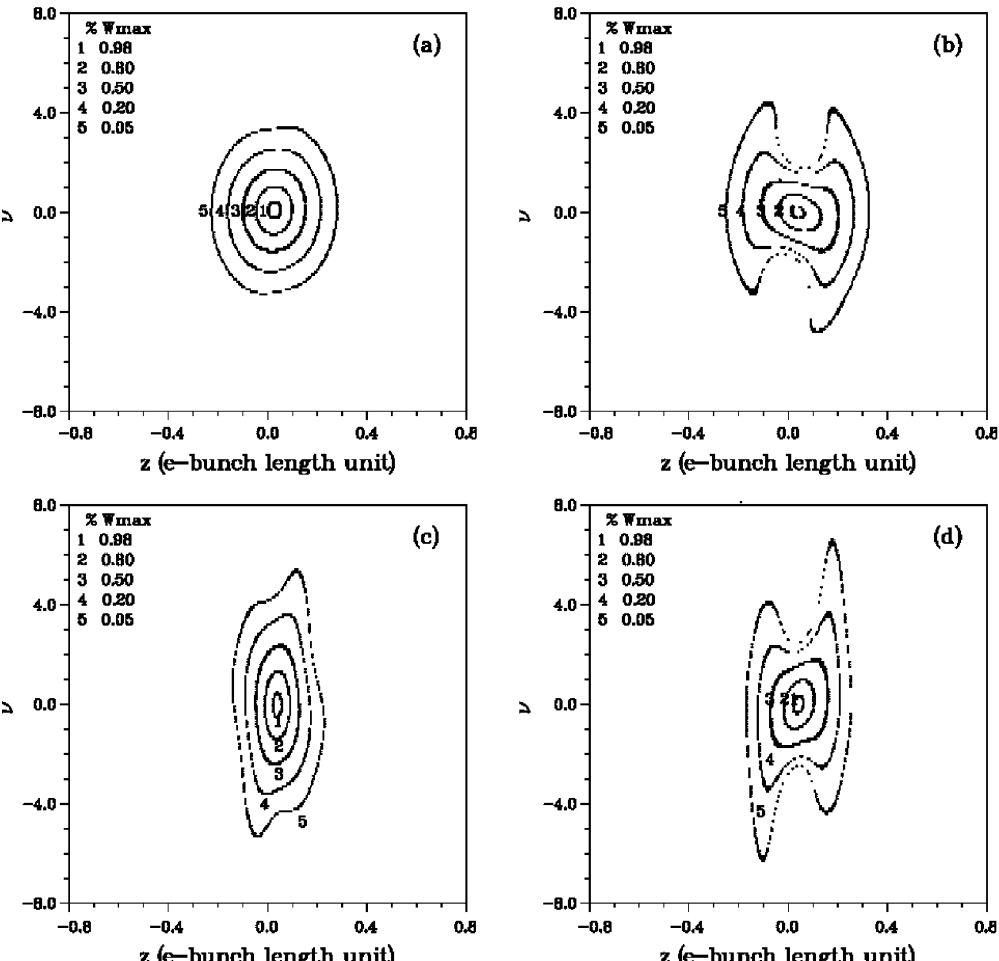
FIG. 9. Phase space contour plot for the third harmonic: (a) linear growth, W max ¼ 3 : 28 (cid:2) 10 (cid:1) 4 ; (b) at the knee, W max ¼ 1 : 35 (cid:2) 10 (cid:1) 3 ; (c) nonlinear harmonic generation region, W max ¼ 3 : 02 (cid:2) 10 (cid:1) 1 ; (d) at the occurrence of the first peak, W max ¼ 1 : 06 ; same parameters as in Fig.